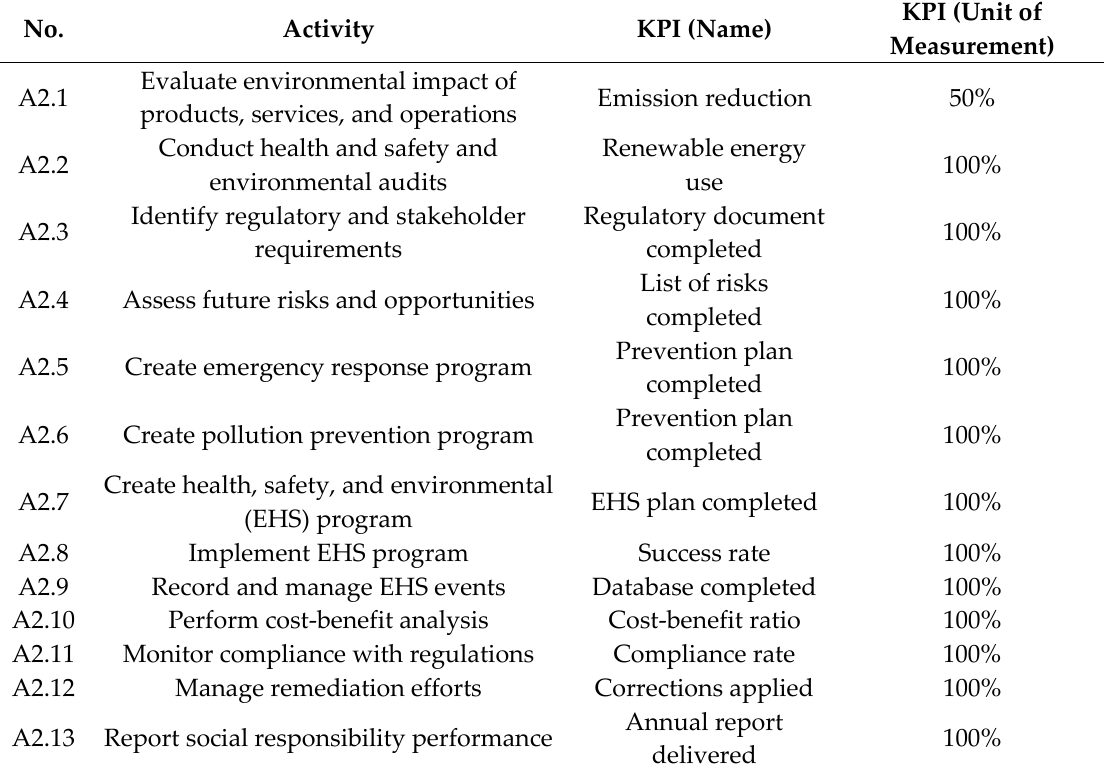
Table 5. P2 process-future